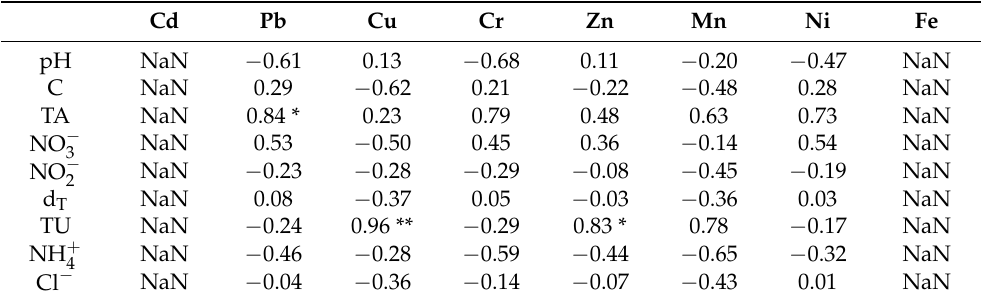
Table 6. Pearson’s correlation coefficient of metals with physico-chemical parameters in groundwa- ter